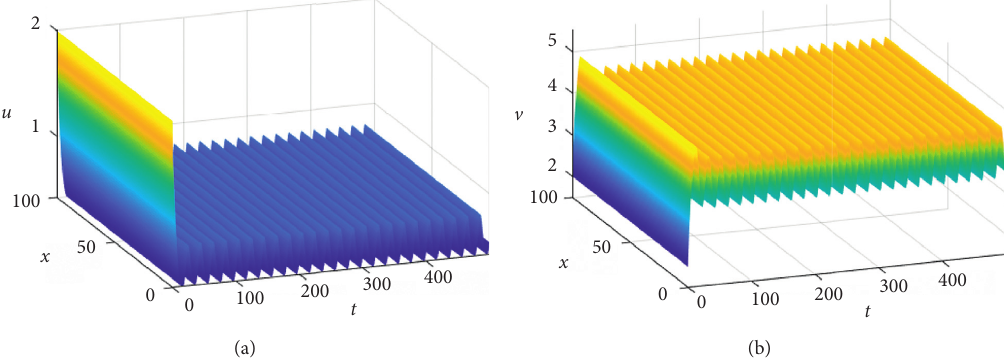
Figure 1: Numerical solutions of system (6a)–(6c): (a) prey population u and (b) predator population v , where r ( t, x ) � 1 . 1 + 0 . 1sin ( π ∗ t /10 ) , K ( t,x ) � 2 + 0 . 5 ∗ cos ( π ∗ t /10 ) , a ( t, x ) � 0 . 8 + 0 . 005 ∗ cos ( π ∗ t /10 ) , b ( t,x ) � 0 . 9 + 0 . 005 ∗ cos ( π ∗ t /10 ) , e ( t, x ) � 0 . 7 − 0 . 002 ∗ cos ( π ∗ t /10 ) , c ( t,x ) � 0 . 02 + 0 . 005 ∗ cos ( π ∗ t /10 ) , δ ( t, x ) � 0 . 12 + 0 . 05 ∗ cos ( π ∗ t /10 ) , μ